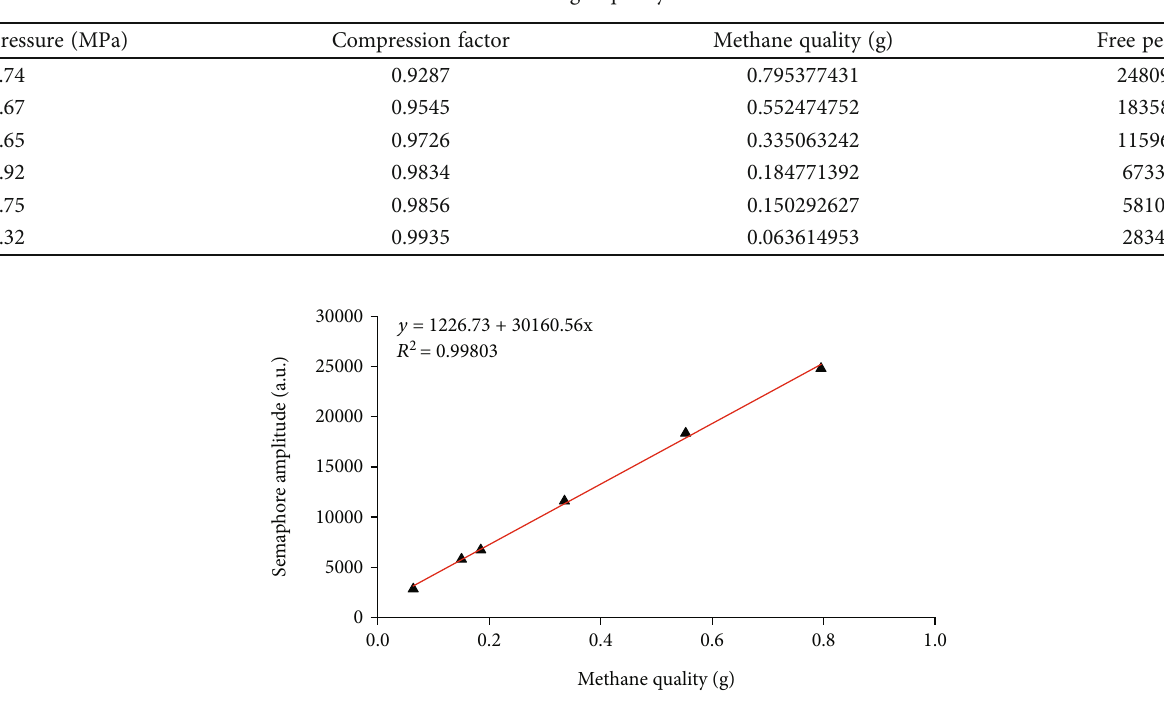
Figure 3: Signal amplitude of methane gas at di ff erent Table 2: Methane gas quality calibration data.